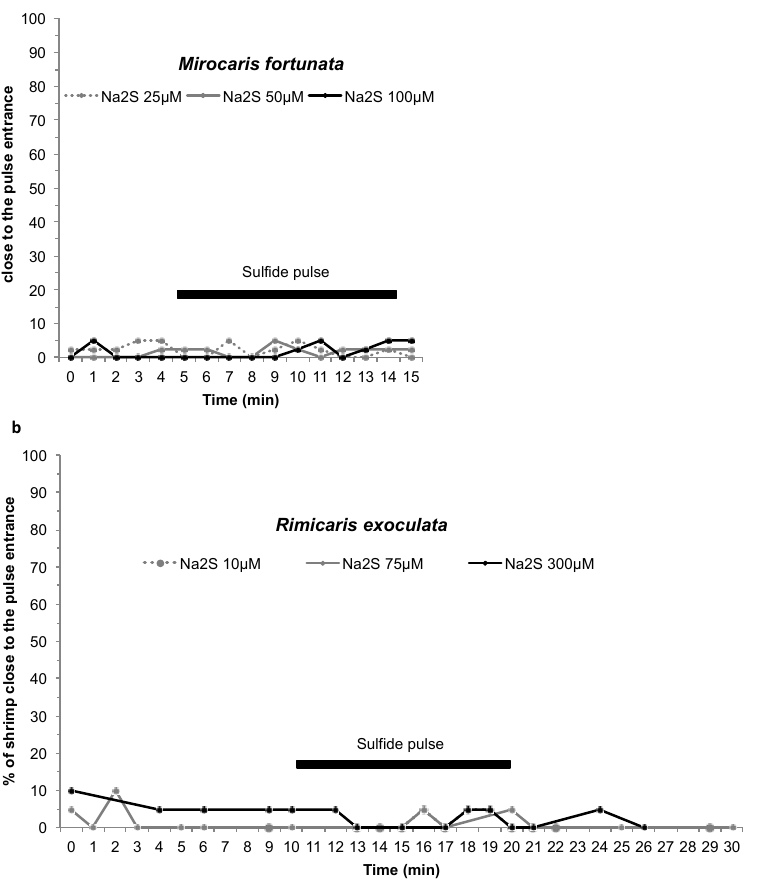
Figure 9. Responses to sulfide pulse stimuli at in situ pressure on a batch of Mirocaris fortunata and Rimicaris exoculata. ( a ) Mirocaris fortunata . Mean % of shrimp over an area of 6-cm 2 surface around the seawater inlet hole. Three injections were carried out with increasing concentrations of sulfide solutions (25, 50 and 100 μ M), and these sulfide pulses are indicated by a black bar along the time scale. One-hour interval separates each sulfide pulse. The experiment was conducted twice on the same batch ( n = 20) of shrimp (i.e., each point represents the mean of two replicates). The experimental setup is depicted in Figure 4c, with the following modifications: removal of the HE2, the two temperature loggers and the diffuser plastic cap; ( b ) Rimicaris exoculata. % of shrimp in contact with the diffuser. Three injections were carried out once on the same batch of shrimp ( n = 20), with increasing concentrations of sulfide solutions (10, 75 and 300 μ M). The number of shrimp close to the pulse entrance was 0 for the experiment with 10 μ M Na2S, and thus the result line is merged with the x-axis. A black bar along the time scale indicates these sulfide pulses. One-hour interval separates each sulfide pulse. The experimental setup is depicted in Figure 4c, with the following modifications: removal of the HE2 and the two temperature loggers.